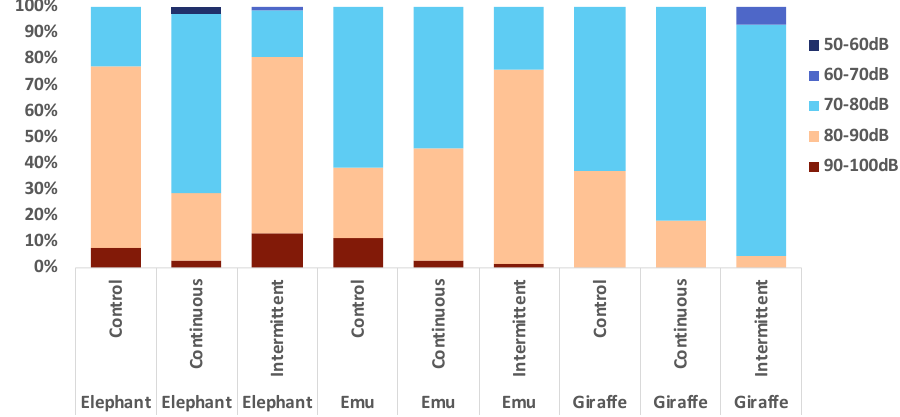
Figure 7. Time spent in enclosure locations during control, continuous, and intermittent sound conditions (mean % of time).